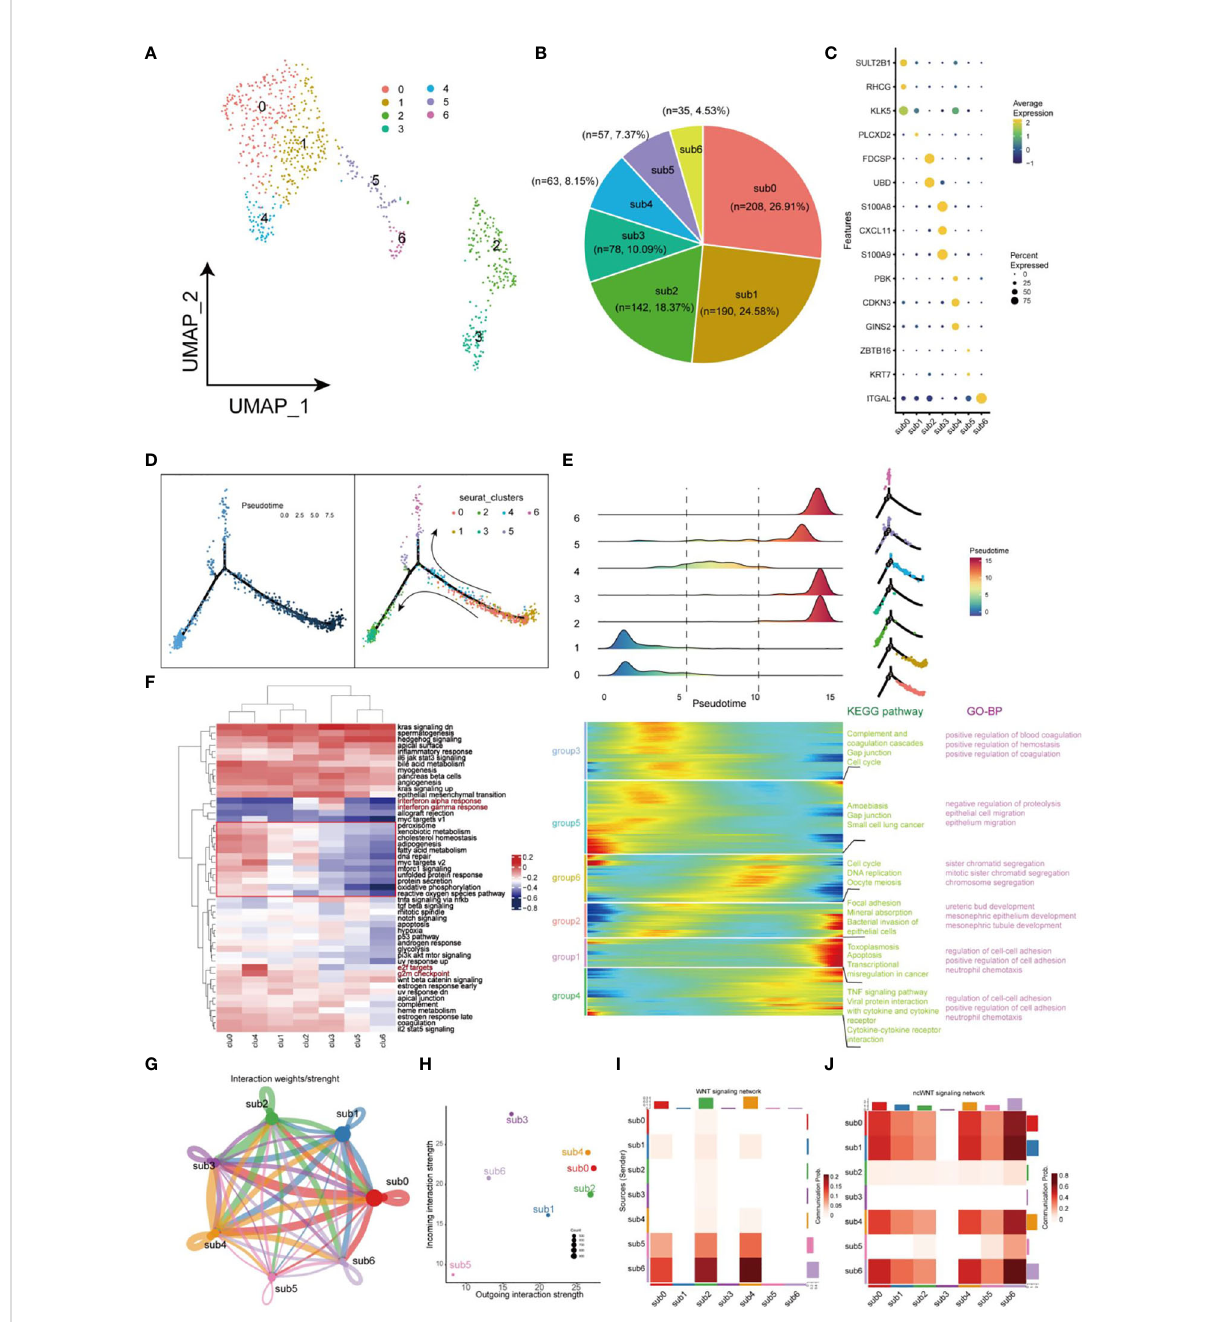
FIGURE 5 Landscape of characteristics of CSCs characterized by single-cell transcriptomic sequencing. (A) UMAP plot of 773 cells in CSCs. (B) Pie chart of the proportion of 7 types of cells in CSCs. (C) Bubble plot of the highest expressed genes within 7 types of cells in CSCs. The size of the dot represents the percentage of gene expression in the cell. (D) Pseudotime ordering of CSCs. The graph on the left is labeled with developmental time, while the graph on the right is labeled with cell state. (E) Plot of clustering of DEGs identi fi ed by the pseudo-temporal progression in CSCs. (F) Heatmap of 50 cancer-related pathways in 7 CSCs subsets using GSVA. (G) Weights/Strength of cell-cell interaction within 7 CSCs subsets. (H) Strength of output/input interaction in different CSCs subsets. (I) Plot of cells which interacted via WNT signaling pathways in CSCs. (J) Plot of cells which interacted via ncWNT signaling pathways in